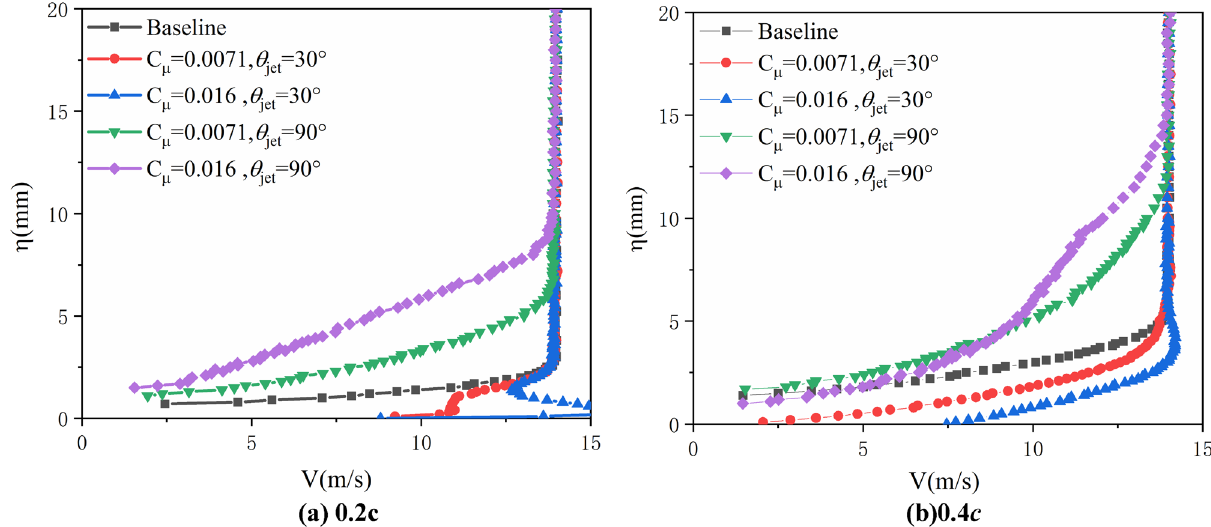
Figure 8. Boundary layer velocity profiles at V ∞ = 15 m/s, α = 20°.